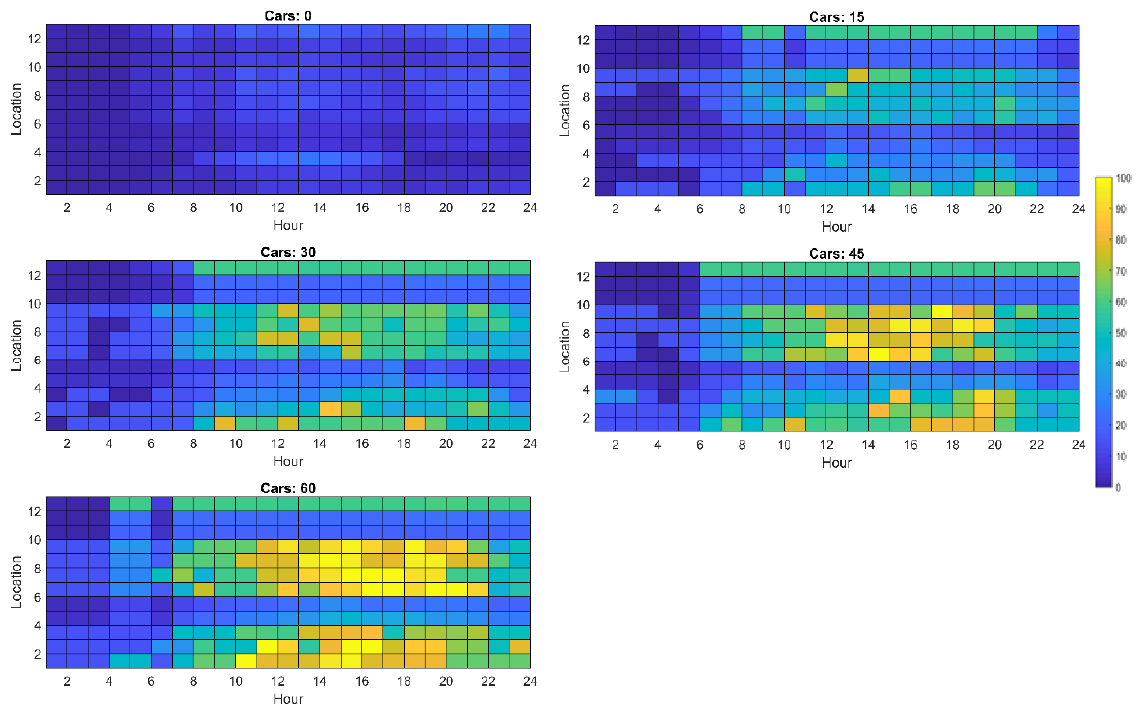
Figure A5. Maximum cable loading (percentage) observed in network 3 with distributed generation OFF.